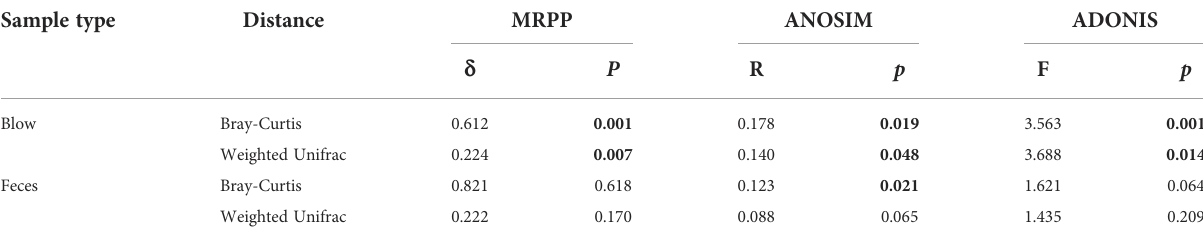
TABLE 2 Signi fi cance tests on the effects of species on the respiratory and intestinal microbial community composition. Sample